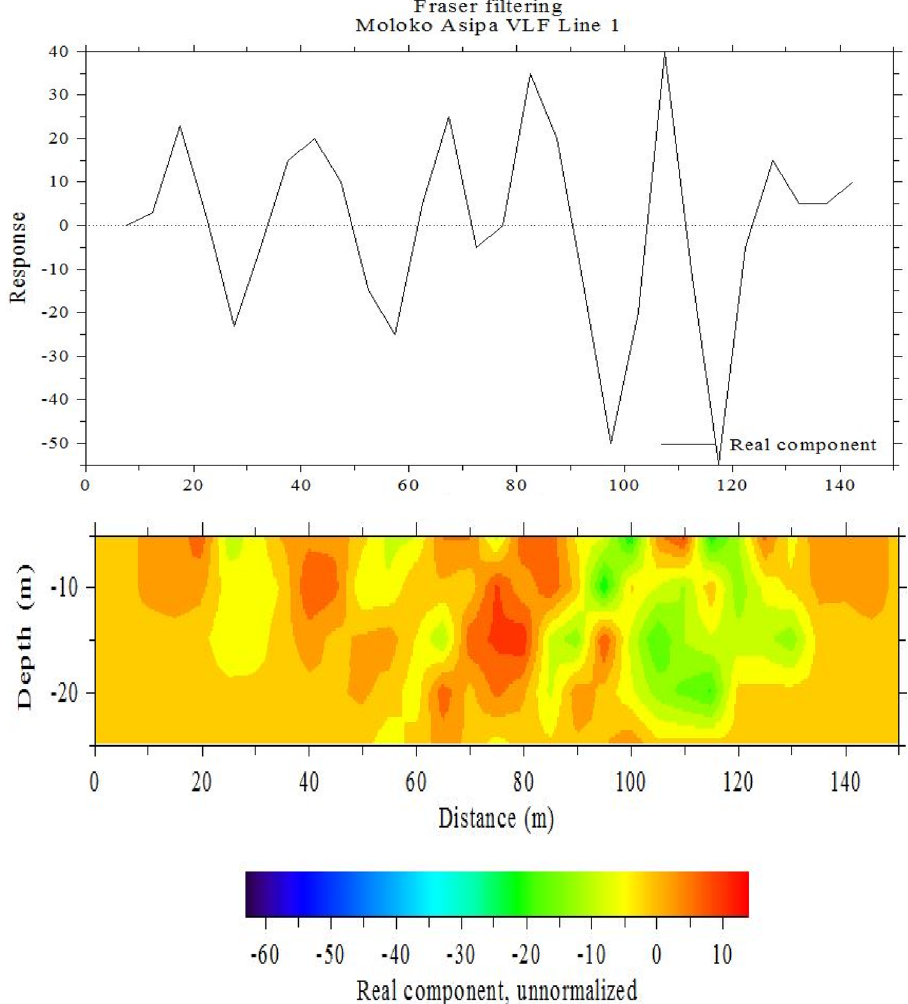
Fig. 2 The Coordinate Layout of the VES Points and the VLF- EM